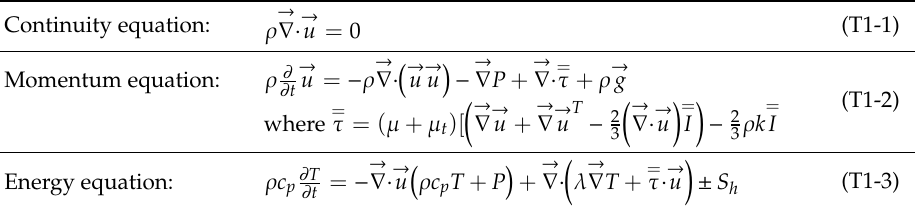
Table 1. Single-phase Eulerian computational fluid dynamics (CFD) model [24,48].